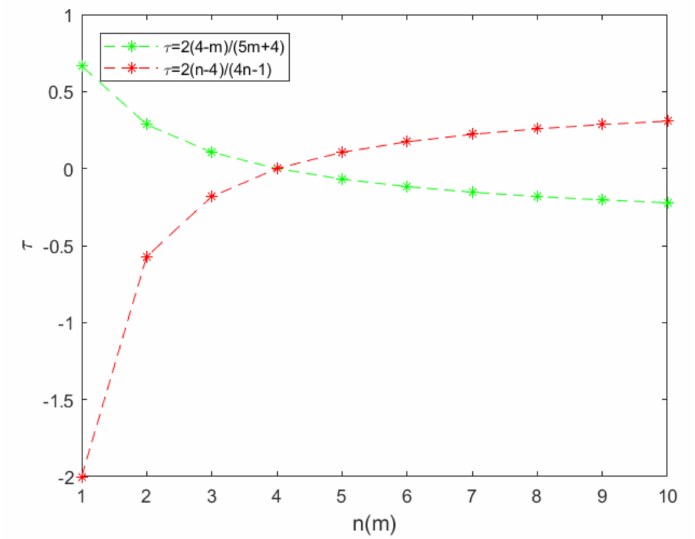
Figure 16. Relationship between the optimal strategy and degrees of concentration in upstream and downstream countries under an ad valorem